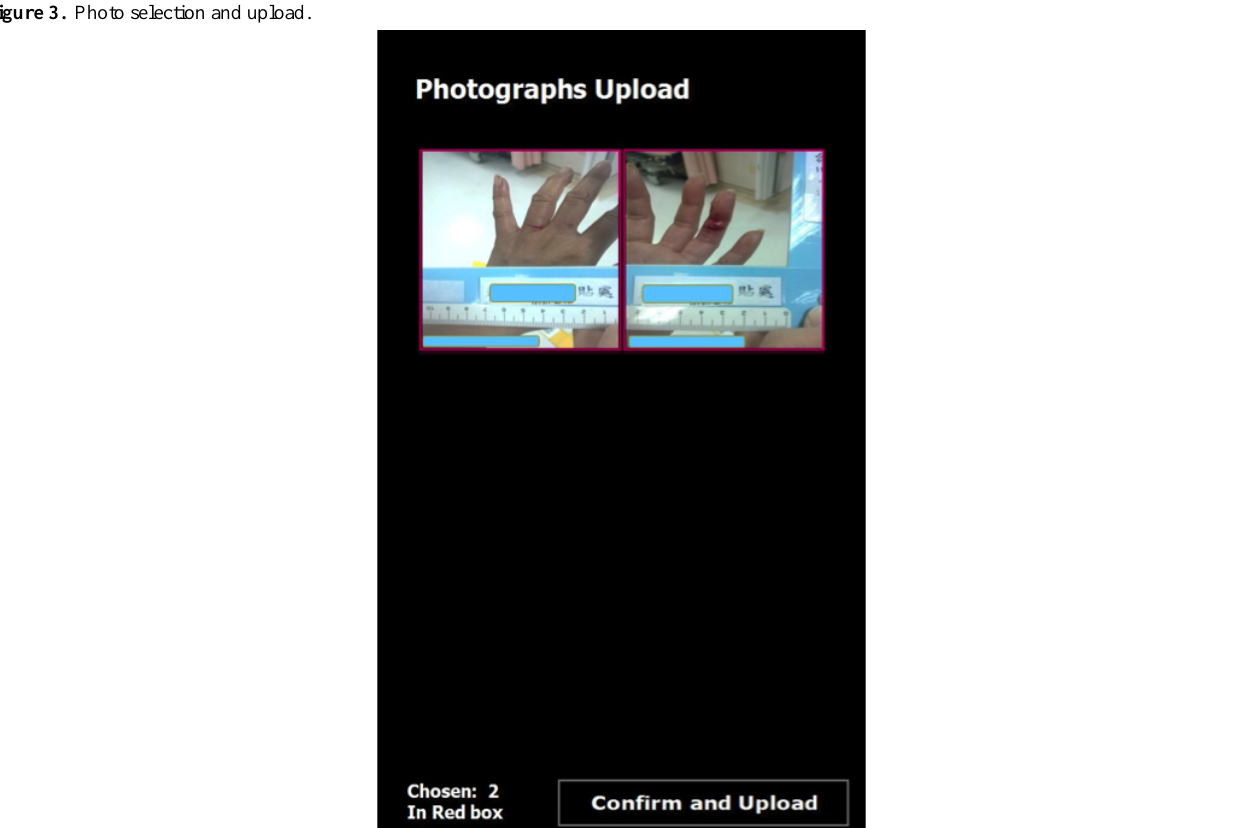
Figure 3. Photo selection and